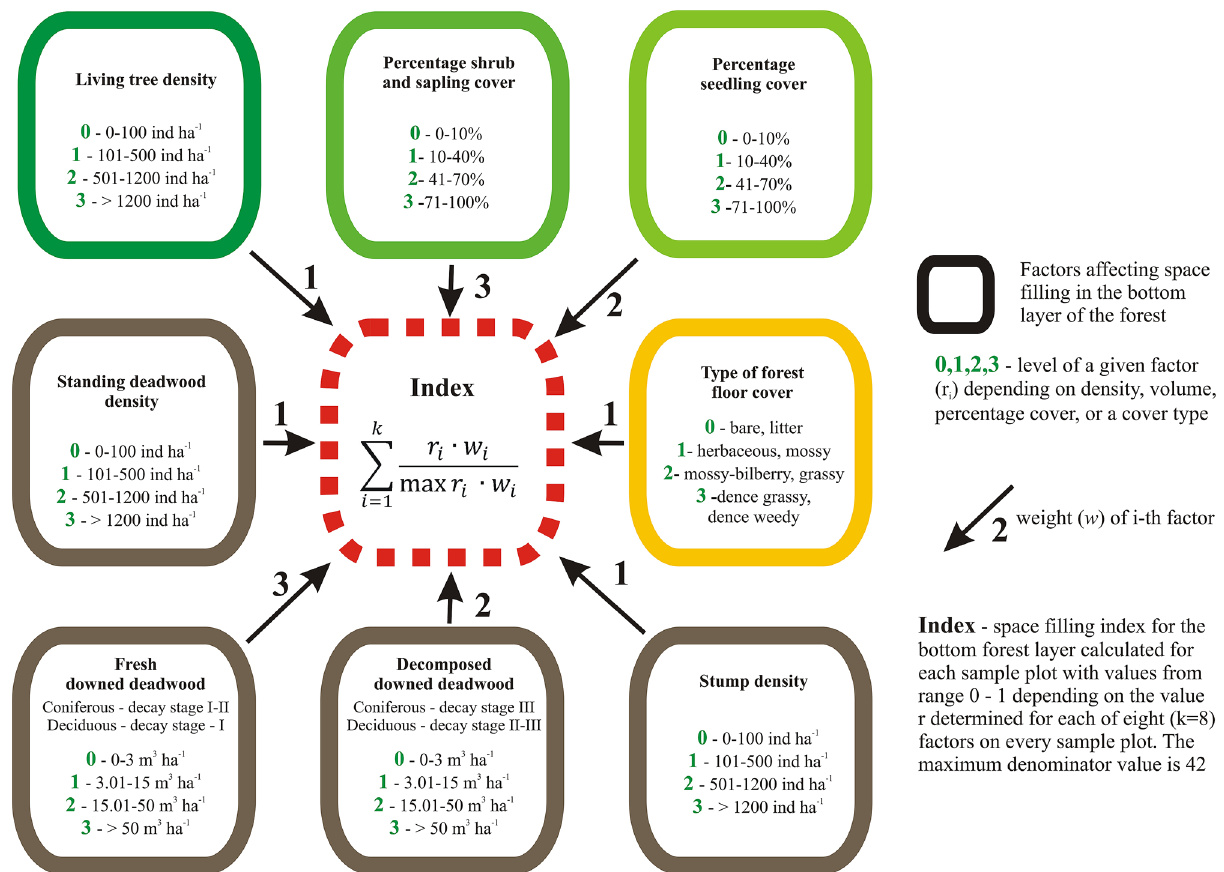
Figure 2. Calculation of the space filling index (SFI) for the bottom layers of the